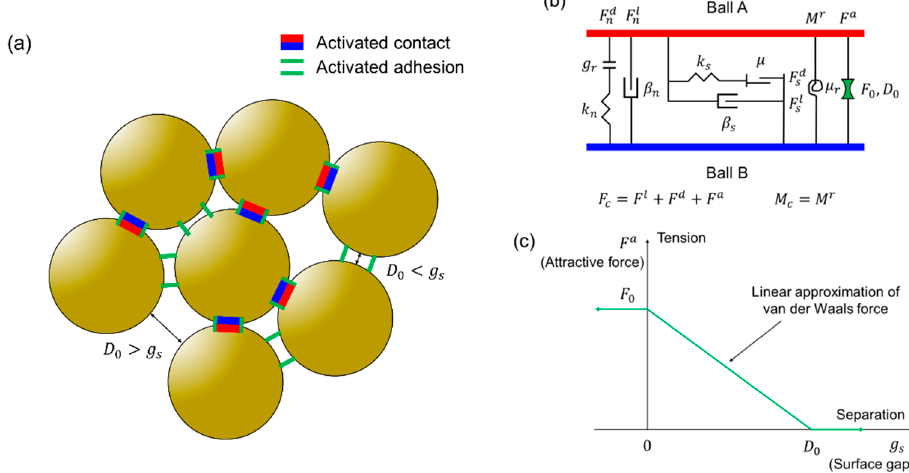
Figure 2. Schematics of adhesive rolling resistance linear contact model: ( a ) conceptual diagram of contact and adhesion; ( b ) configuration of contact force ( F c ) and contact moment ( M c ) between two ball elements; ( c ) linear approximation of the relationship between attractive force ( F a ) and surface gap ( g s ) for simulating